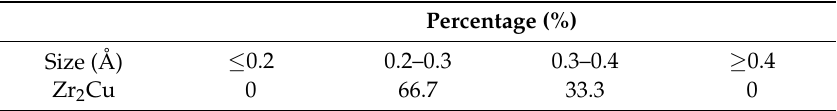
Table 1. Size distribution of intrinsic unfilled spaces detected by a structural model containing more than 50,000 atoms of the Zr 2 Cu tetragonal phase.